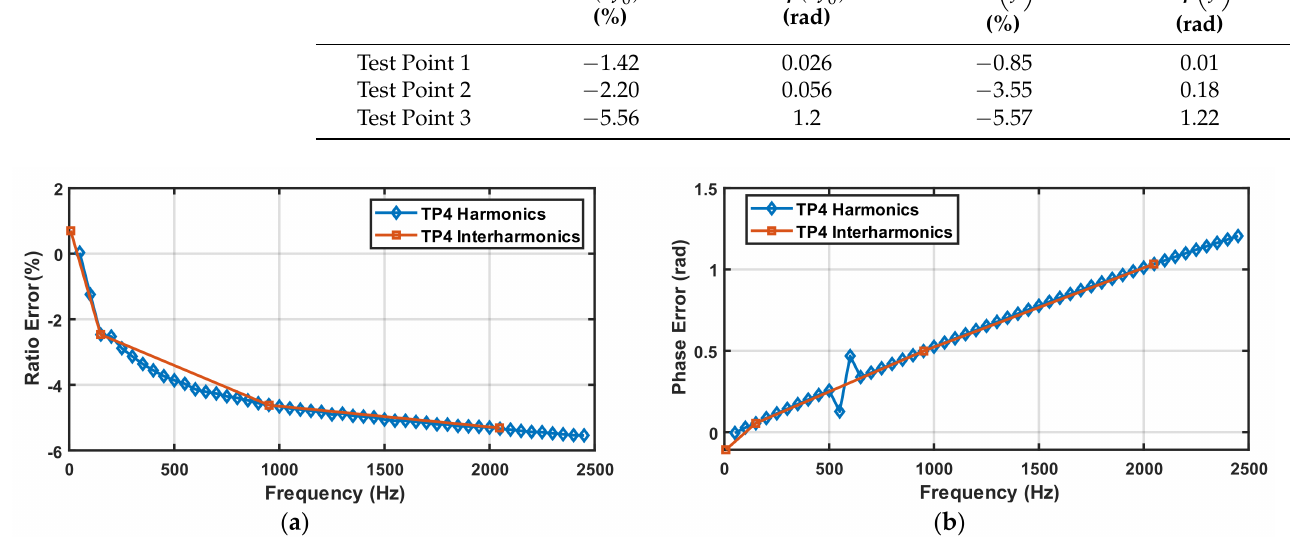
Figure 9. Ratio ( a ) and phase ( b ) errors of LPVT under test in FTN conditions with harmonic components (rhombus markers) and interharmonic components (square